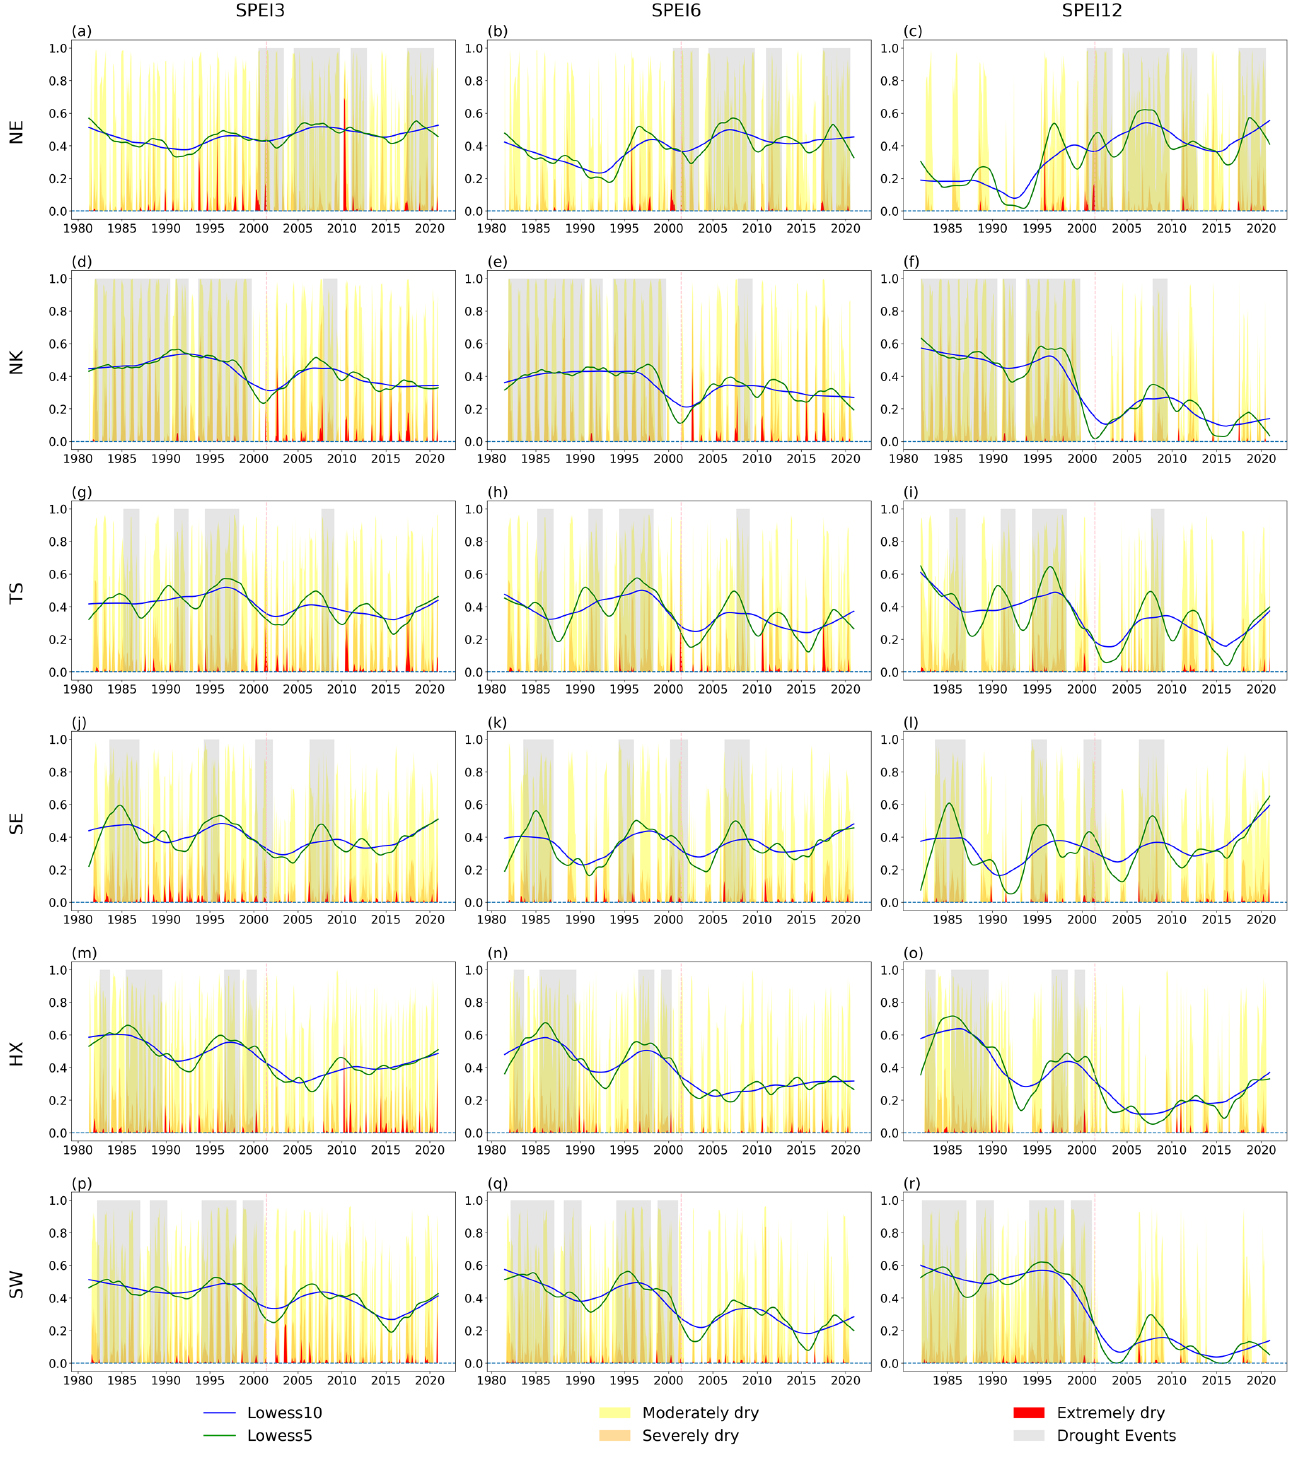
Figure 8. Temporal evolution of percentage of drought area for SPEI3, SPEI6, and SPEI12 over six subregions. Subplots ( a – r ) represent the percentage change of drought area at different time scales (SPEI3, SPEI6, and SPEI12).